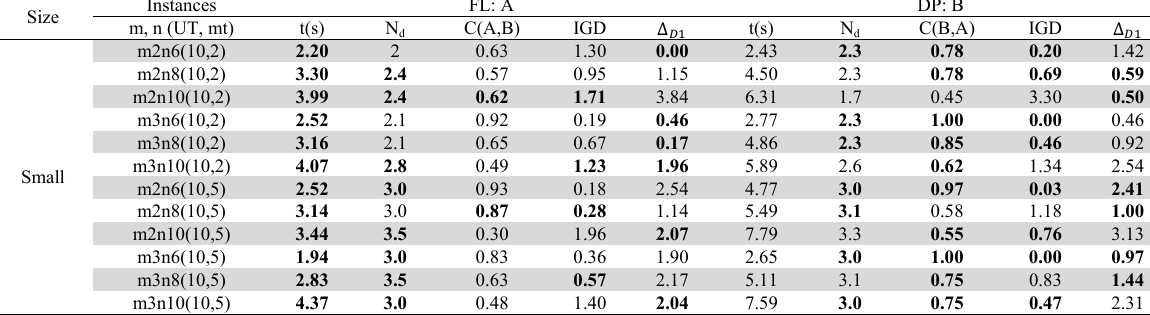
Results of the different decoding methods of the M-NSGA- Ⅱ